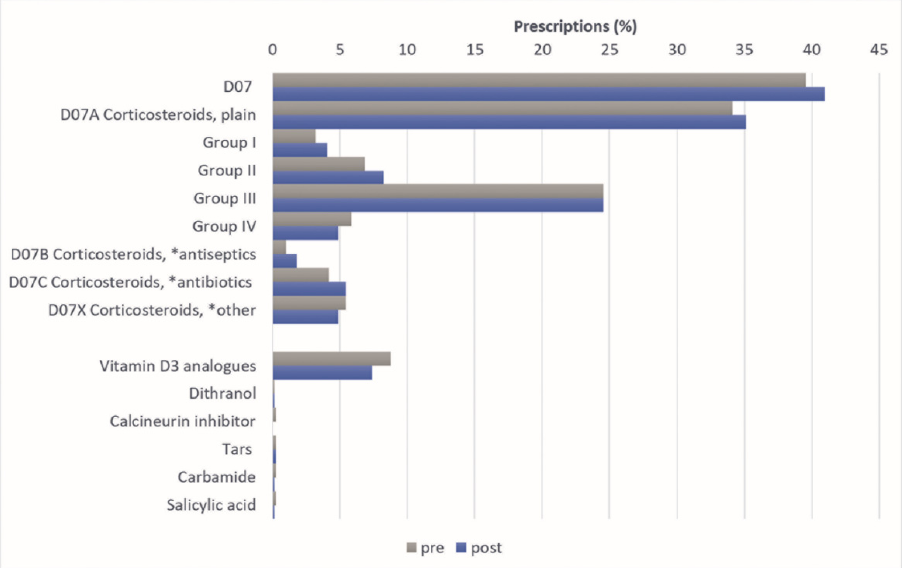
Figure 1. Topical therapy in psoriasis patients one year prior to one year after nursing home admission (N = 718); at least one prescription. * in combination with.